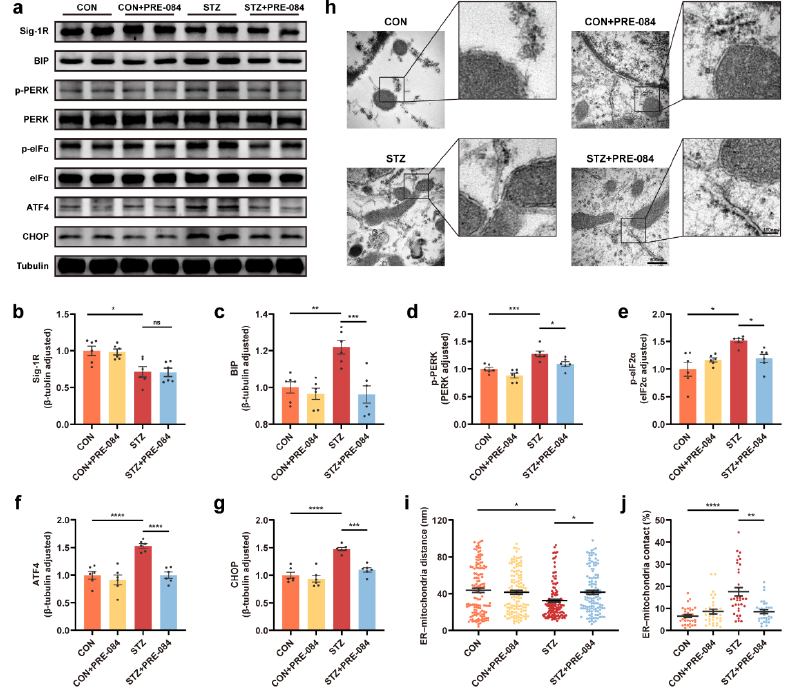
Figure 2. Sig-1R activation modulated ERS and astrocytic ER-mitochondrion contact in the hippocampus of mice with T1DM. ( a – g ) Representative Western blot and quantitative analyses of Sig-1R, BIP, p-PERK, PERK, p-eIF2 α , eIF2 α , ATF4, and CHOP protein expression in CON, CON + PRE-084, STZ, and STZ + PRE-084 mice ( n = 6). ( h ) Representative electron micrographs of ER-mitochondria associations in astrocytes of the mouse hippocampus. The scale bars are 500 and 100 nm. ( i , j ) Quantitative analysis of the distance ( n = 124–132; 3 mice per group) ( i ) and contact proportion ( n = 32–34; 3 mice per group) ( j ) of ER-mitochondria associations. The data were presented as mean ± SEM and analyzed using one-way ANOVA with Tukey’s multiple comparisons test, Welch’s ANOVA test followed by Dunnett’s T3 multiple comparison tests, and Kruskal-Wallis test followed by Dunn’s multiple comparison tests. * p < 0.05; ** p < 0.01; *** p < 0.001; **** p < 0.0001. Sig-1R, sigma-1 receptor; ER, endoplasmic reticulum; ERS, ER stress; T1DM, type 1 diabetes mellitus; BIP,